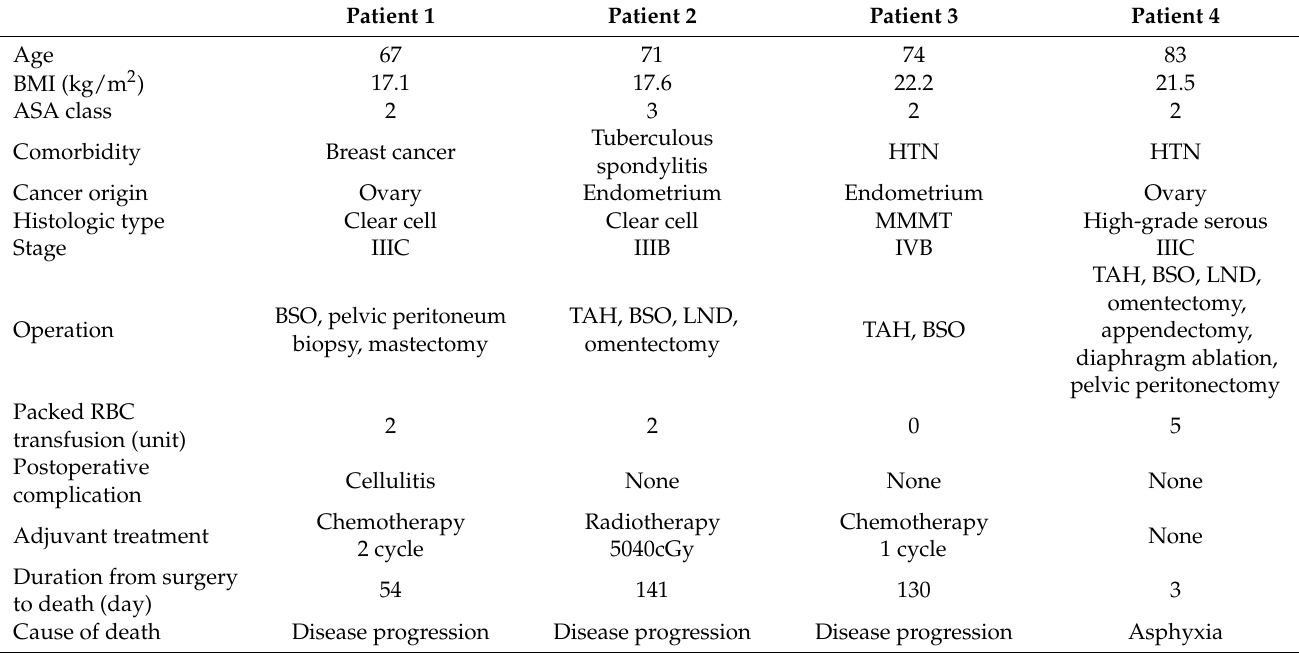
Table 4. Analysis of patients who died within 6 months of